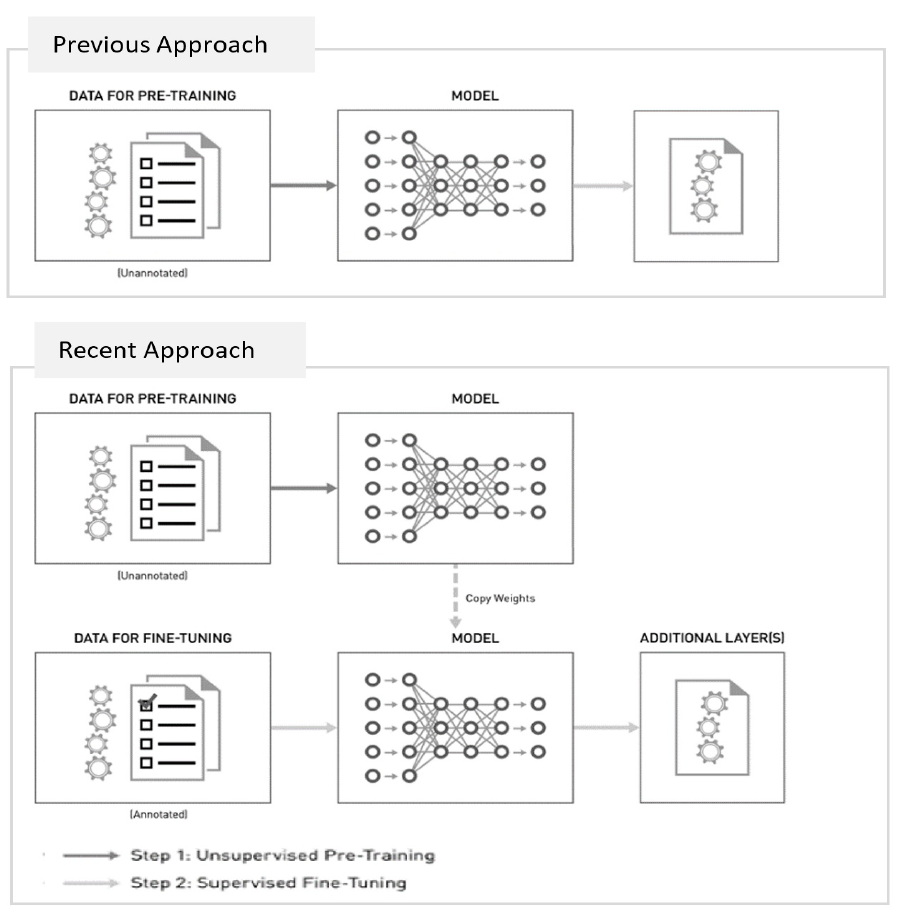
Figure 2. Previous vs. recent